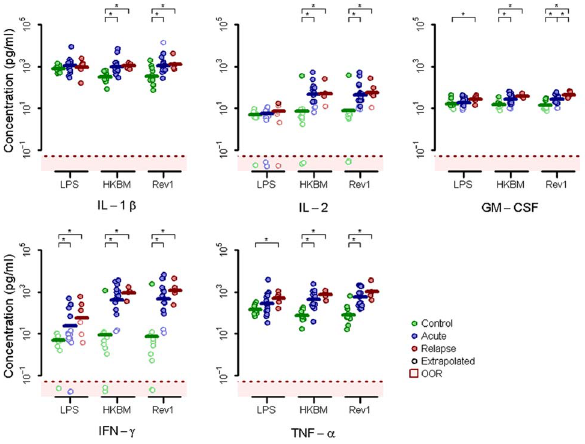
Figure 4. PBMC cytokine secretion after stimulation measured by multiplex immunoassay. IL-1 b , IL-2, GM-CSF, IFN- c , and TNF- a protein secretion by from control donors or acute or relapse brucellosis patients after stimulation with LPS, heat-killed B. melitensis (HKBM), or the heat-killed B. melitensis vaccine Rev1, as measured by multiplex immunoassay (asterisk indicates p # 0.05). Concentrations indicated by open circles were extrapolated beyond the assay standard curve and values in the red shaded zone fell outside the observable range (OOR).